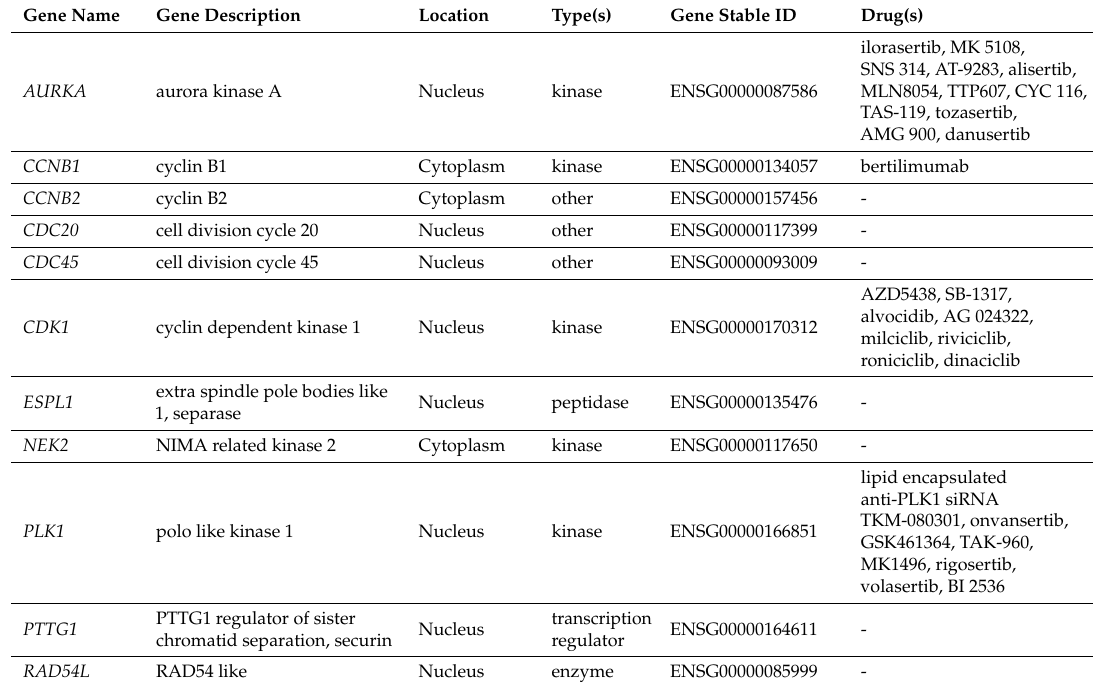
Table 3. List of 11 S switches intersected between IHC and PAM50